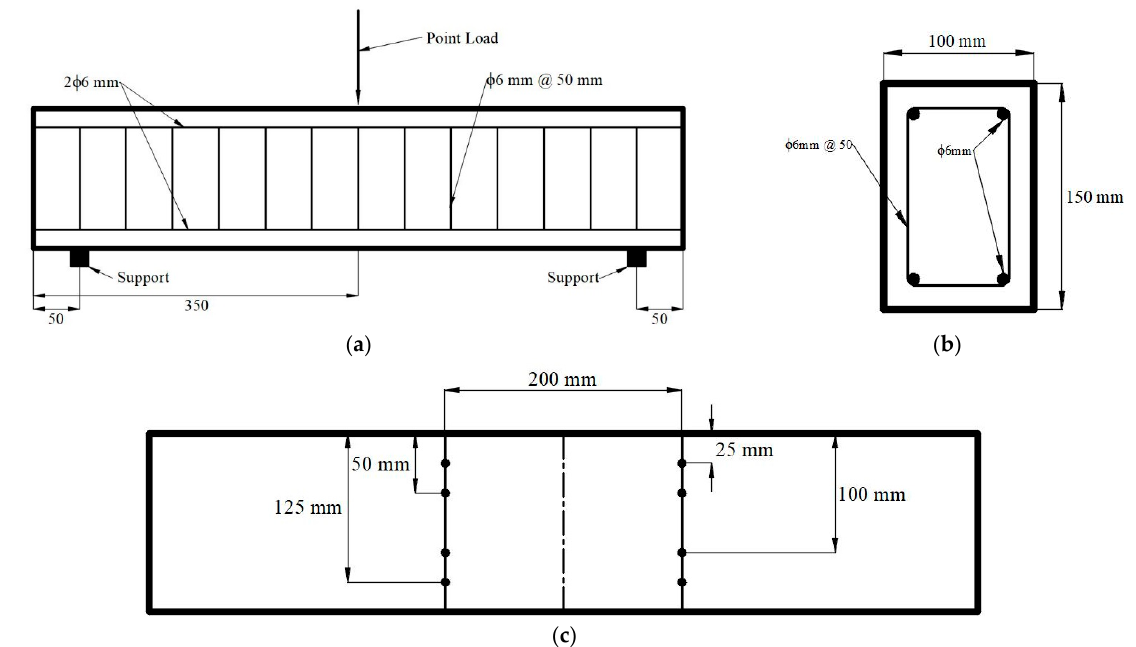
Figure 3. Details of the reinforced concrete beams: ( a ) longitudinal section (in mm); ( b ) cross-section; ( c ) DEMEC point locations.